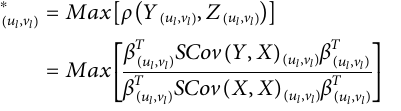
log p k k (cid:2) 1